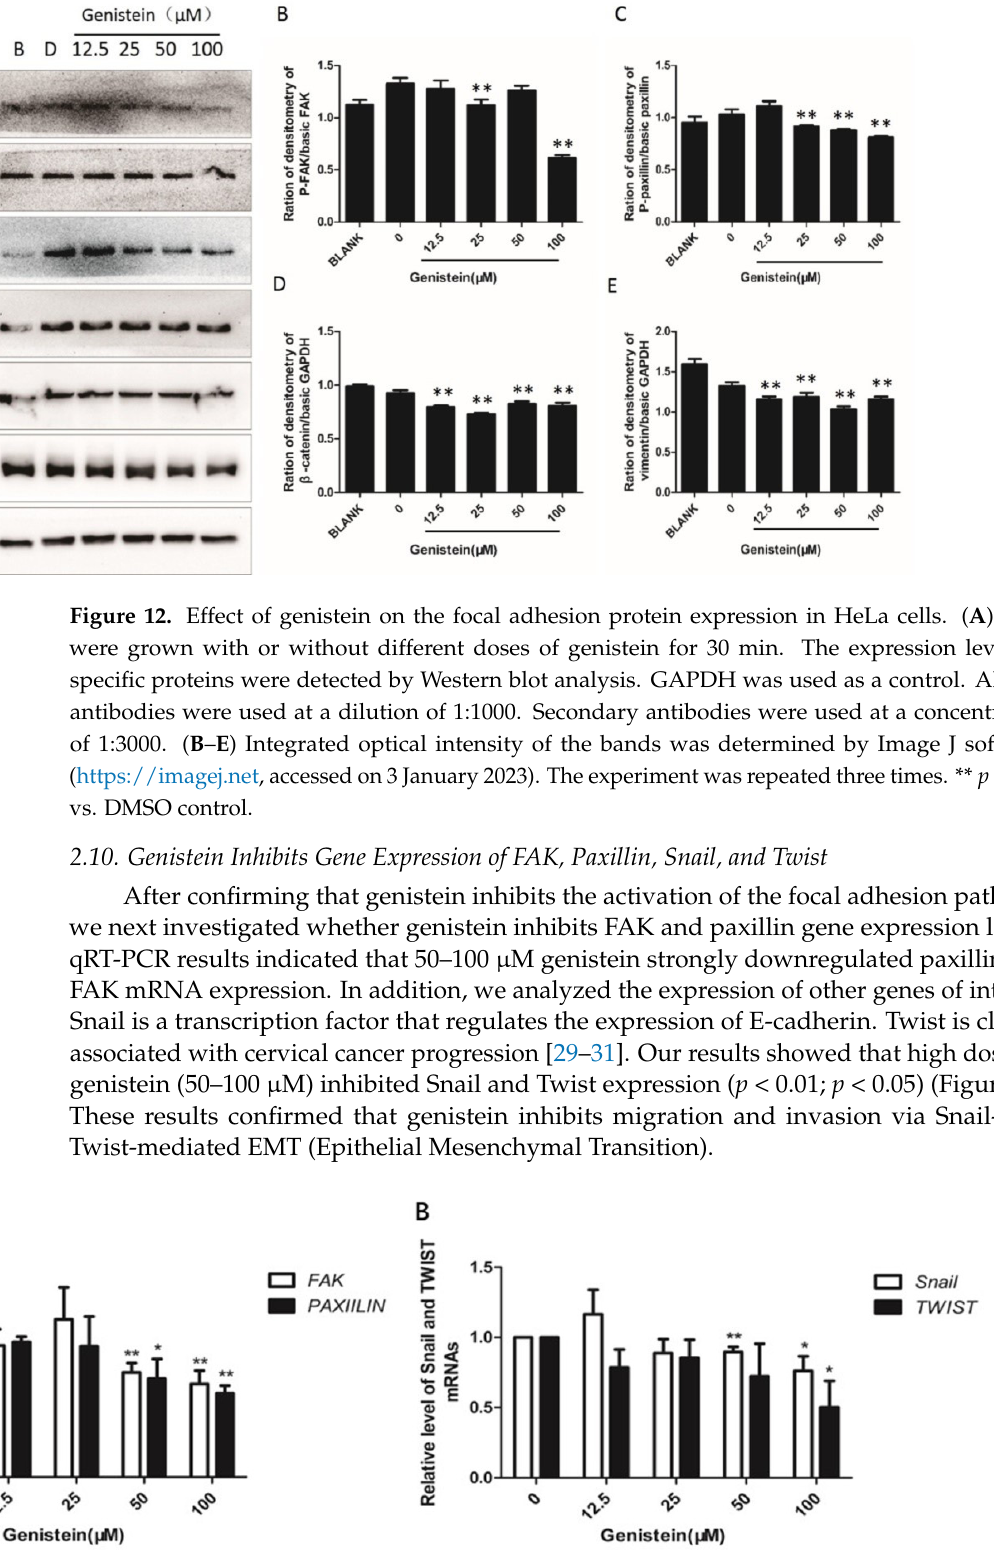
Figure 13. Effect of genistein on specific gene expression in HeLa cells. ( A ) Genistein inhibited FAK and paxillin, and ( B ) Snail and Twist mRNA expression in HeLa cells. Gene expression was analyzed by qRT-PCR. mRNA relative expression levels were evaluated using the 2 −(cid:52)(cid:52) Ct method. GAPDH was used as an internal control. The experiment was repeated three times. ** p < 0.01 vs. DMSO control; * p < 0.05 vs. DMSO